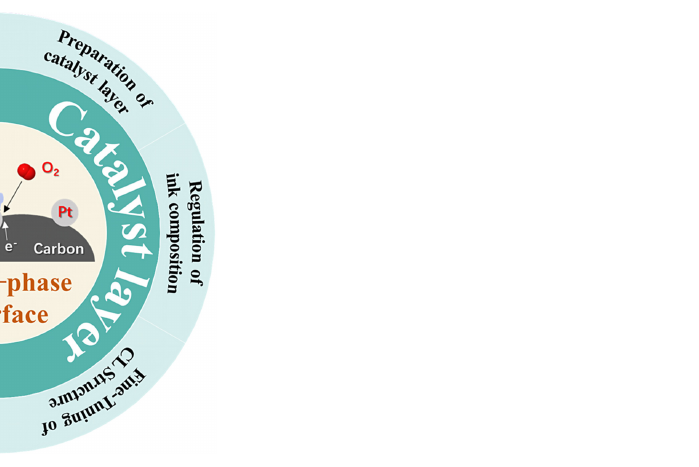
Scheme 1. An overview of strategies for PEMFC cost reduction and performance improvement.